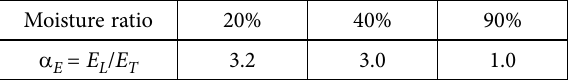
transverse Young’s modulus) T